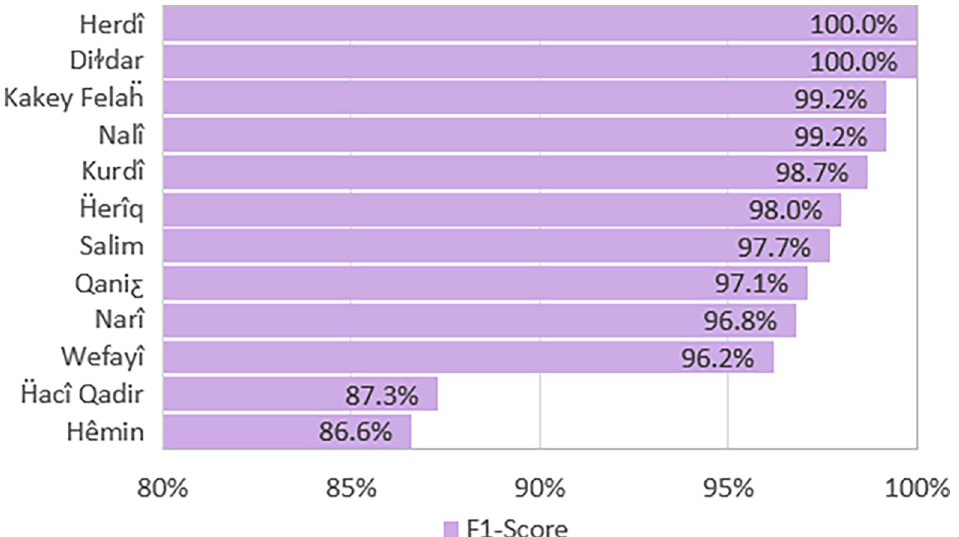
Fig 2. Metrical pattern classification results, separated by